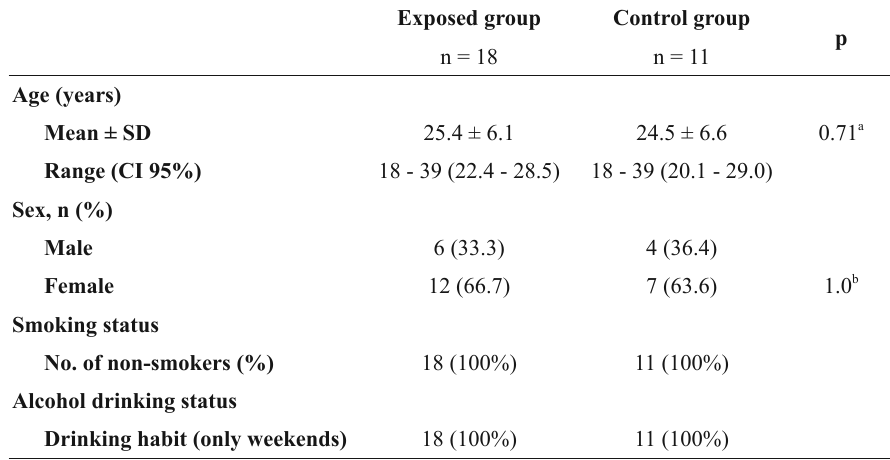
Characterization of exposed and control